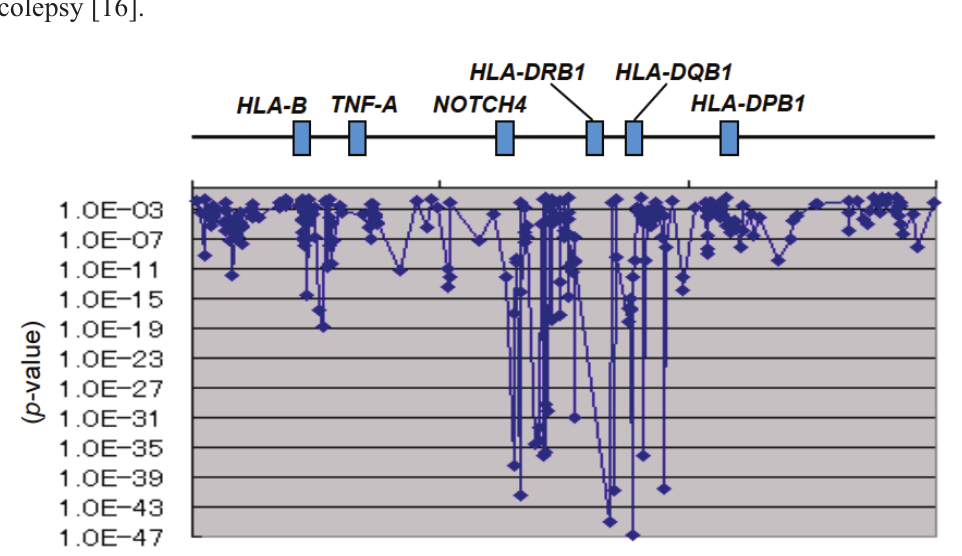
Figure 3. GWAS confirmed the most strong association of the HLA-DR/DQ region with narcolepsy